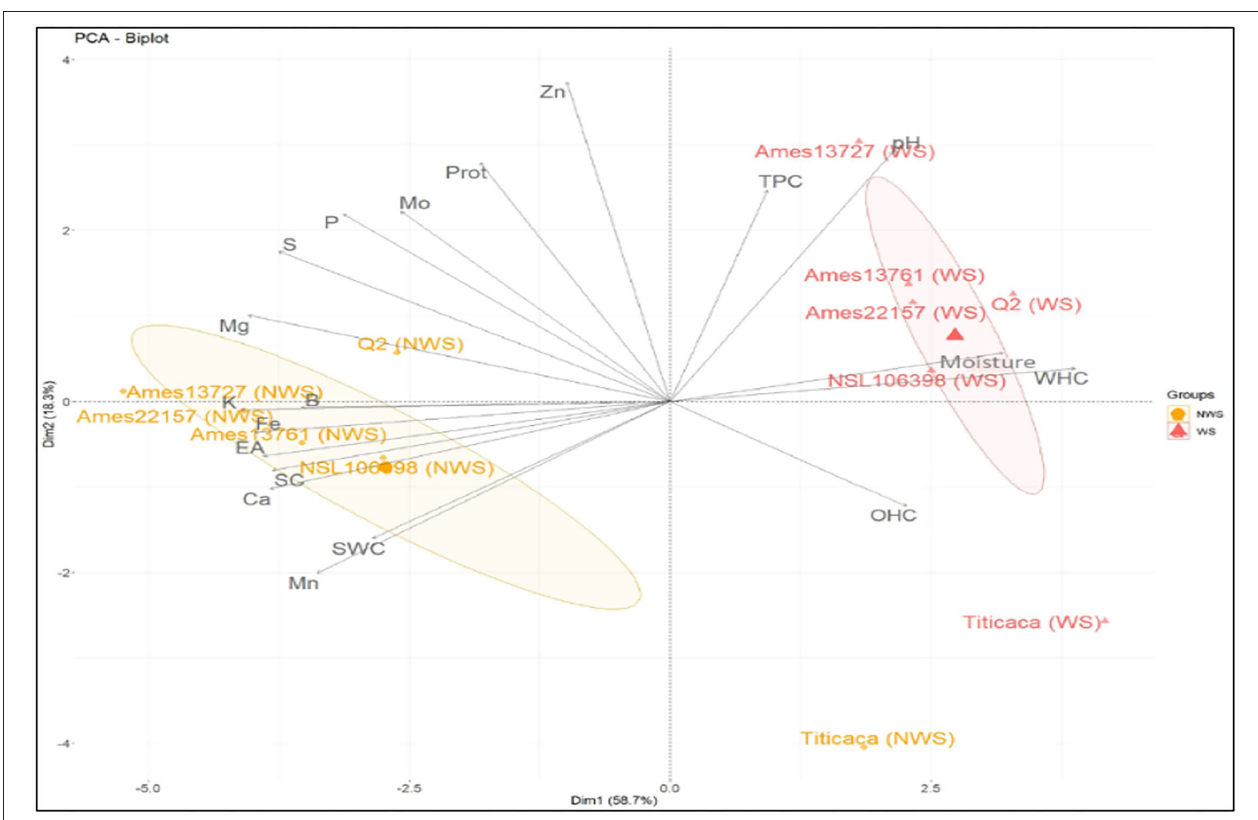
FIGURE 6 | PCA analysis of different